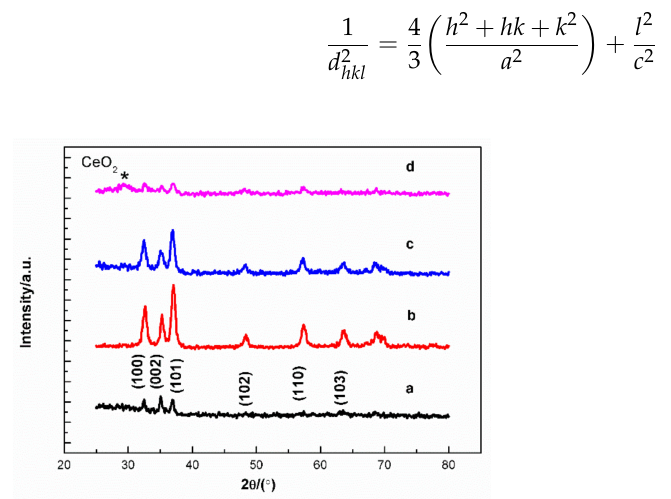
Figure 2. XRD patterns of un-( a ), 3% ( b ), 6% ( c ) and 12% ( d ) Ce-doped ZnO